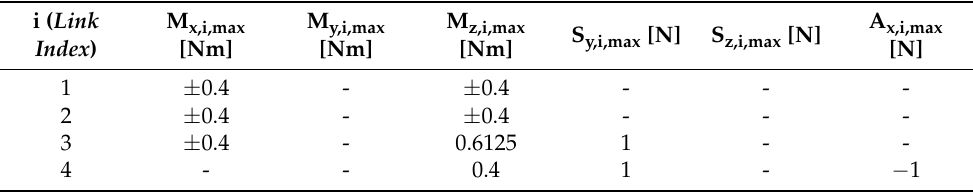
Table 2. Maximum non-null influence coefficients due to the unit force F e,z (= 1 N) of case